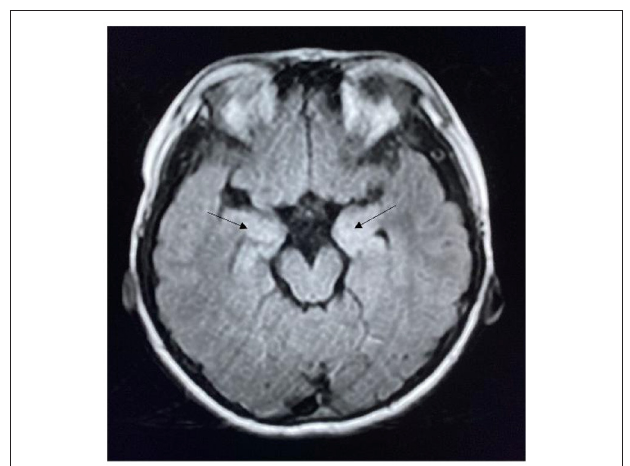
FIGURE 1 | MRI of a patient with anti-NMDAR encephalitis showing bilateral hippocampal lesions (arrow).